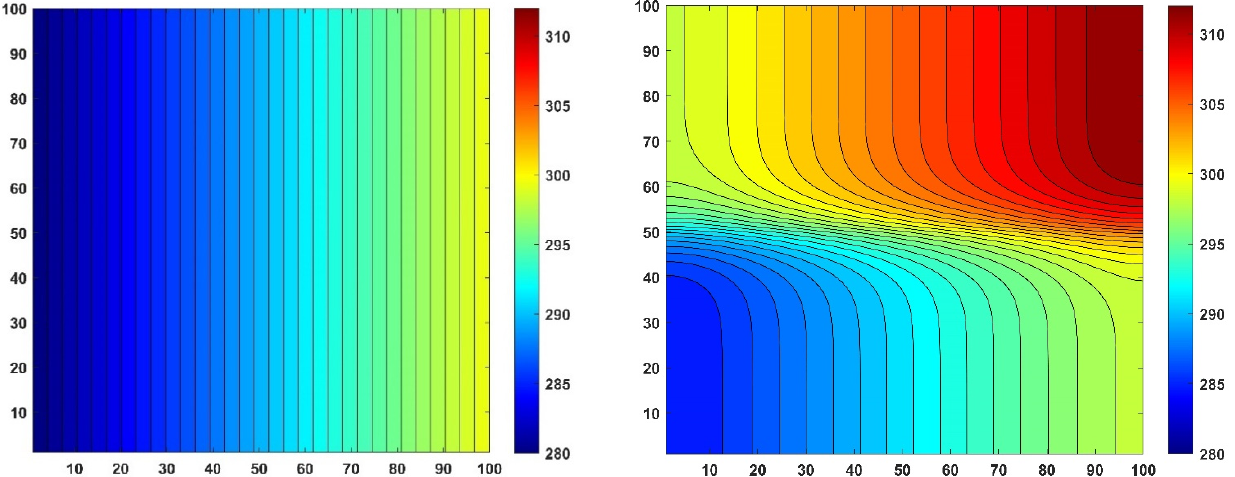
Figure 14. The temperature distribution contour in Kelvin in the case of Experiment 6 at initial ( left part ) and final time ( right part ), in the case of a surface area. The coordinates in cm units are represented by the numbers on the vertical and horizontal axes of the contours, which are the cell indices as well.